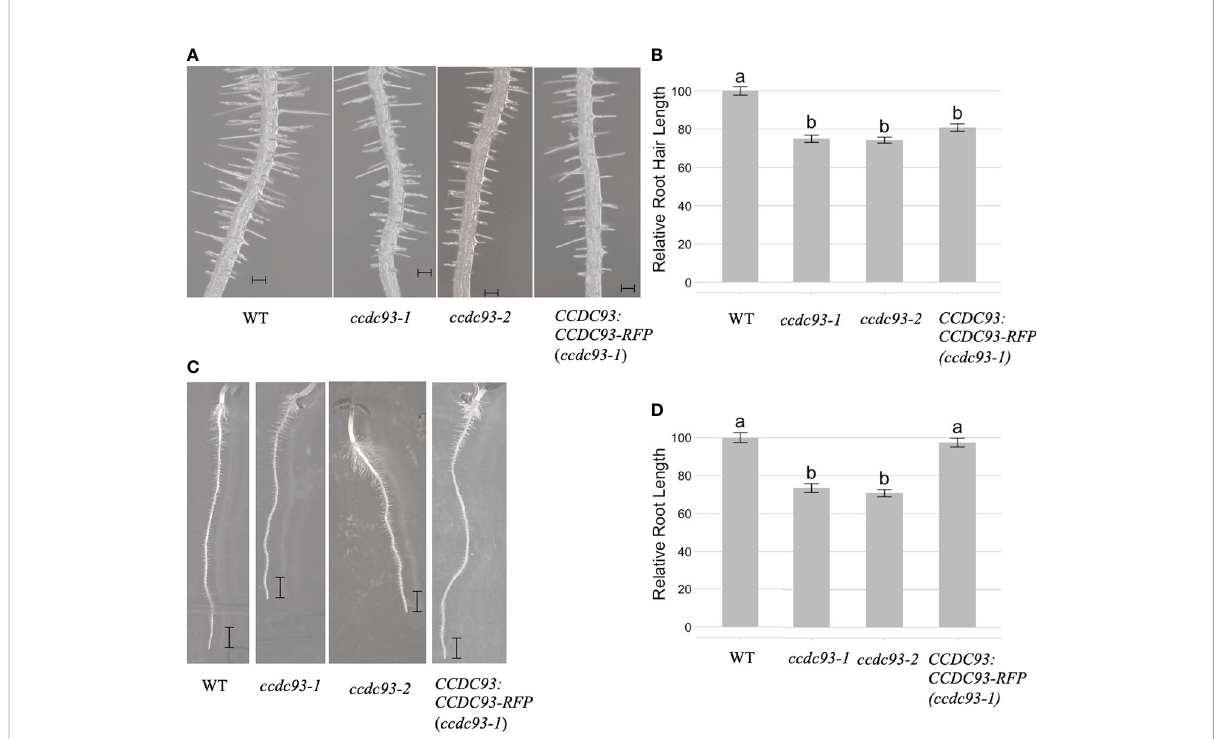
FIGURE 7 CCDC93 is required for root and root hair growth in Arabidopsis seedlings. (A) Root hairs of fi ve-day-old wild type, ccdc93-1 and ccdc93-2 seedlings grown on 1X MS media are shown, Scalebars are equal to 100 m m. (B) Quanti fi cation of fi ve-day old root hair length of seedlings grown on 1X MS media. Data presented are the pooled results of three independent experiments in which 15 root hairs per seedling and 10 seedlings per genotype were measured. (C) Expression of a C-terminal RFP fusion to CCDC93 in the ccdc93-1 background resulted in complementation of the ccdc93-1 short root phenotype. Scalebars are equal to 1mm. (D) Relative root growth (%) of the indicated genotypes. Letters above the bars represent statistically signi fi cant groupings at the level of p < 0.001 as determined by analysis of variance (ANOVA) and Tukey ’ s honestly signi fi cance difference